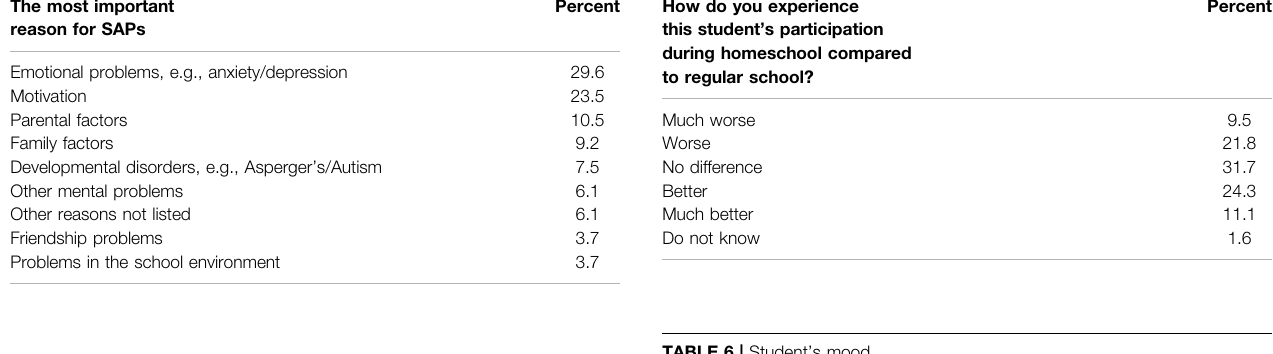
TABLE 6 | Student ’ s mood.